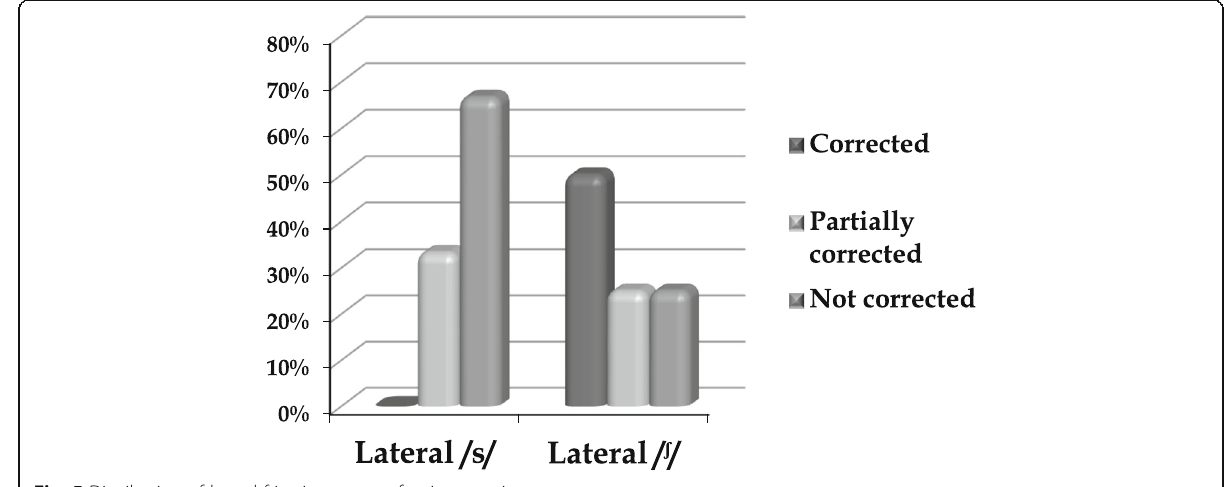
Fig. 5 Distribution of lateral fricatives errors after intervention